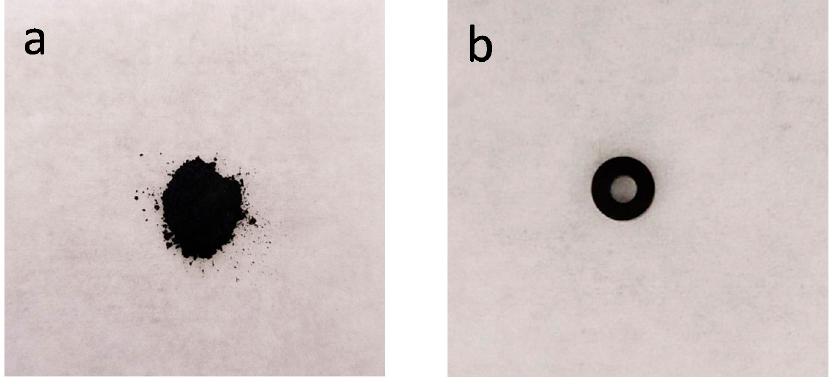
Figure 1. ( a ) The photo of FeNi 3 @C pristine powder. ( b ) The photo of FeNi 3 @C/paraffin ring-shaped sample. ring-shaped